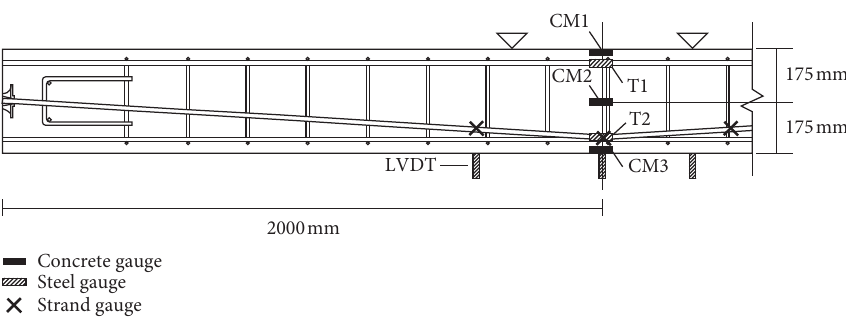
Figure 5: Positions and naming of